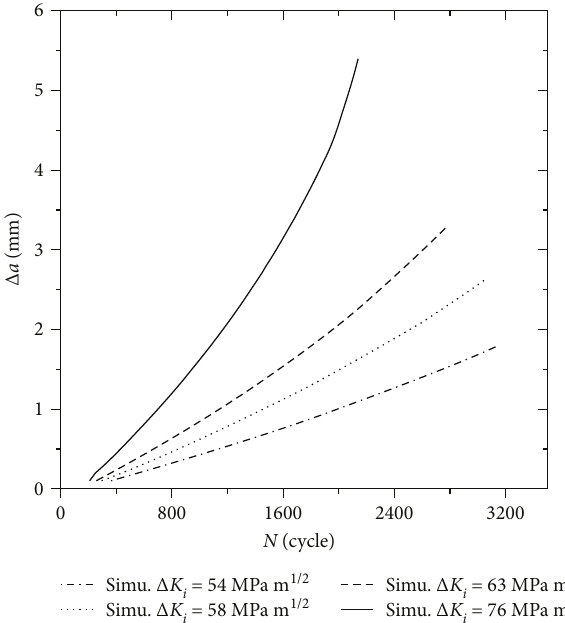
Figure 8: The crack growth curves with varying Δ K constant amplitude loading at R = 0 1 .